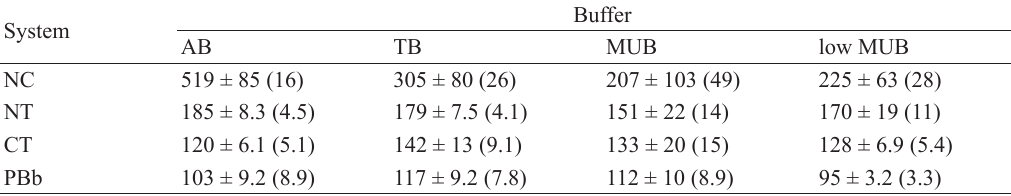
Soil phosphatase activity 1,2 (ug p-NP g -1 dry soil) obtained with different buffers 3 and under different land- use systems (n=5).